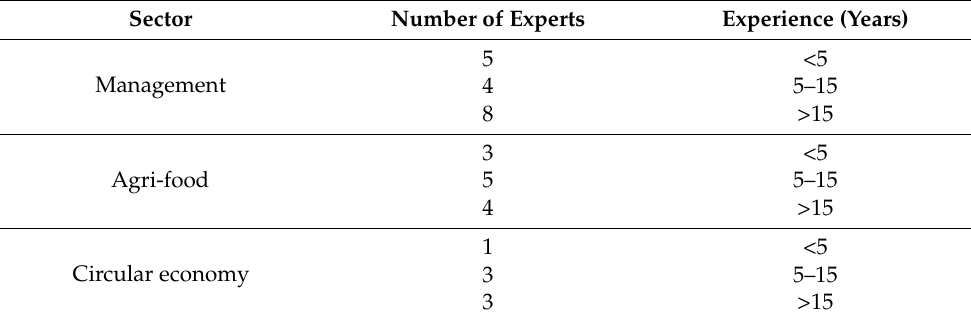
Table 2. Focus group structure.